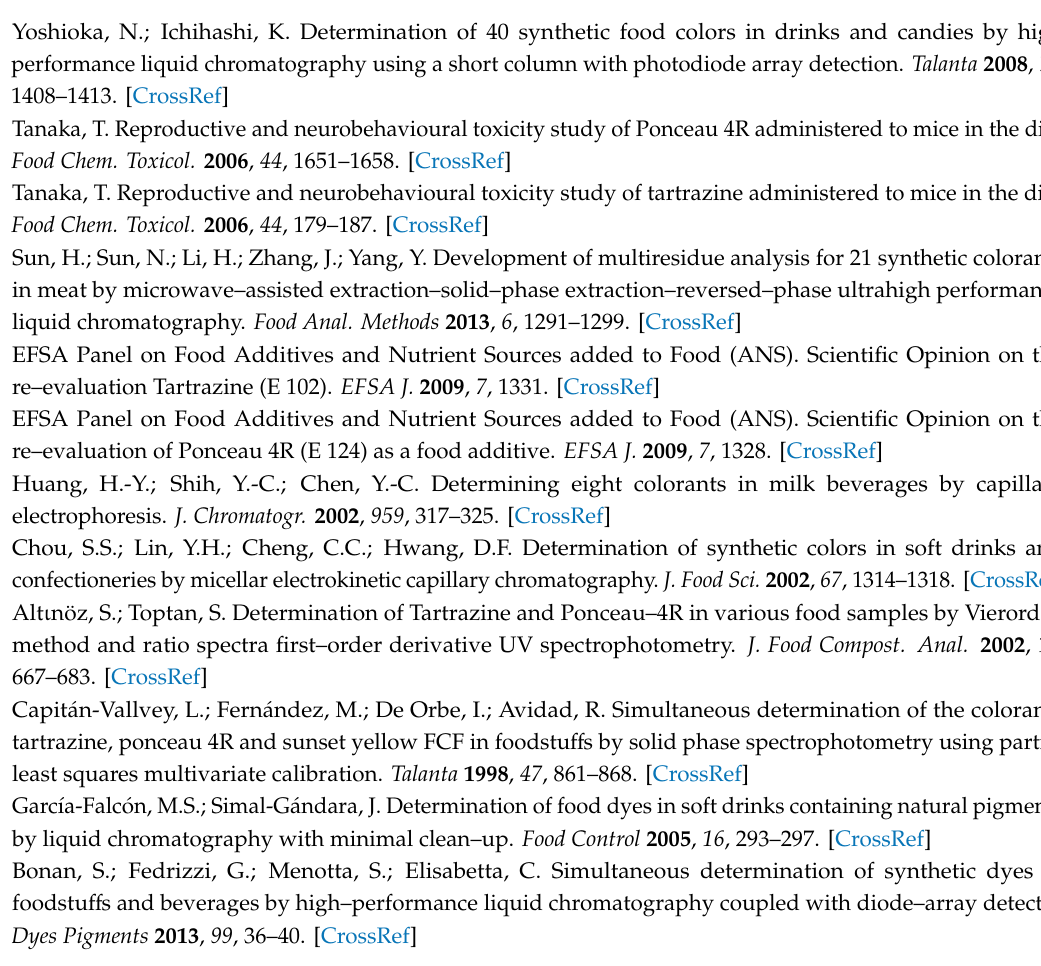
Figure S1: Cyclic voltammograms of ponceau 4R (A) and tartrazine (B) at various scan rates, Figure S2: Anodic AdSDPV peak currents of ponceau 4R and tartrazine parallelly recorded on five TiO 2 / ErGO / GCEs, Figure S3: AdSDPVs responses of ponceau 4R and tartrazine in dependence on storage time, Table S1: Anodic peak currents of ponceau 4R and tartrazine in the presence of various interfering